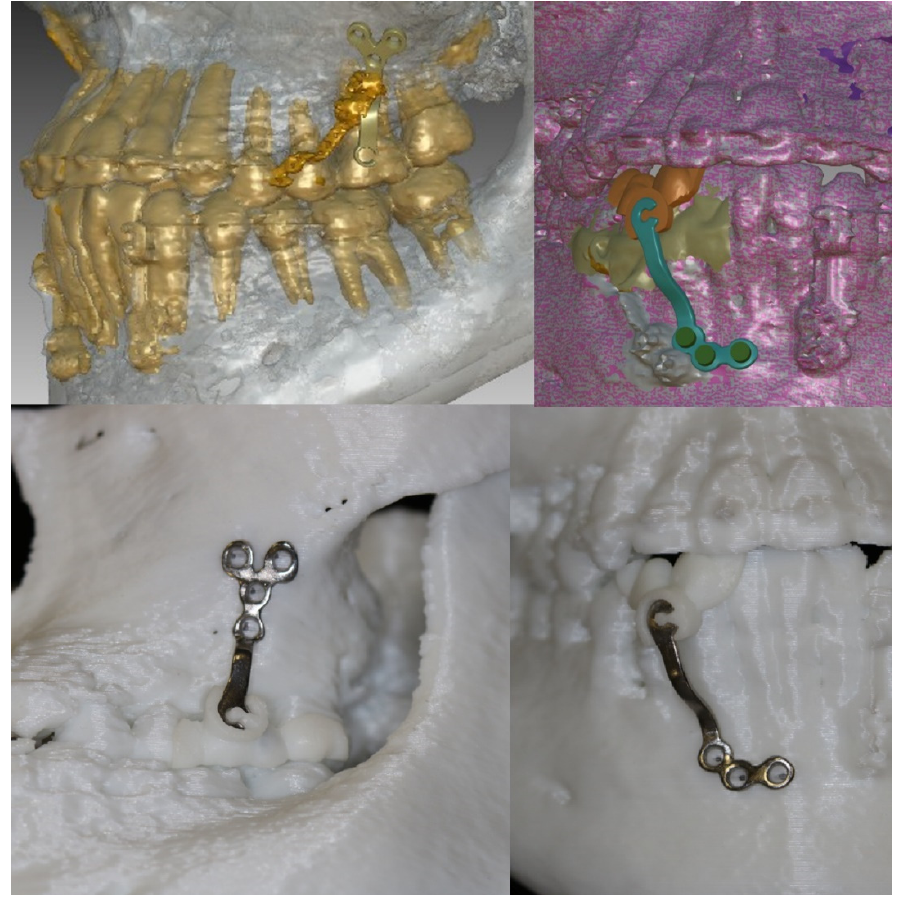
Figure 3. Preoperative simulation and application of fabricated customized plates and transfer jig on the individualized rapid prototyping model.